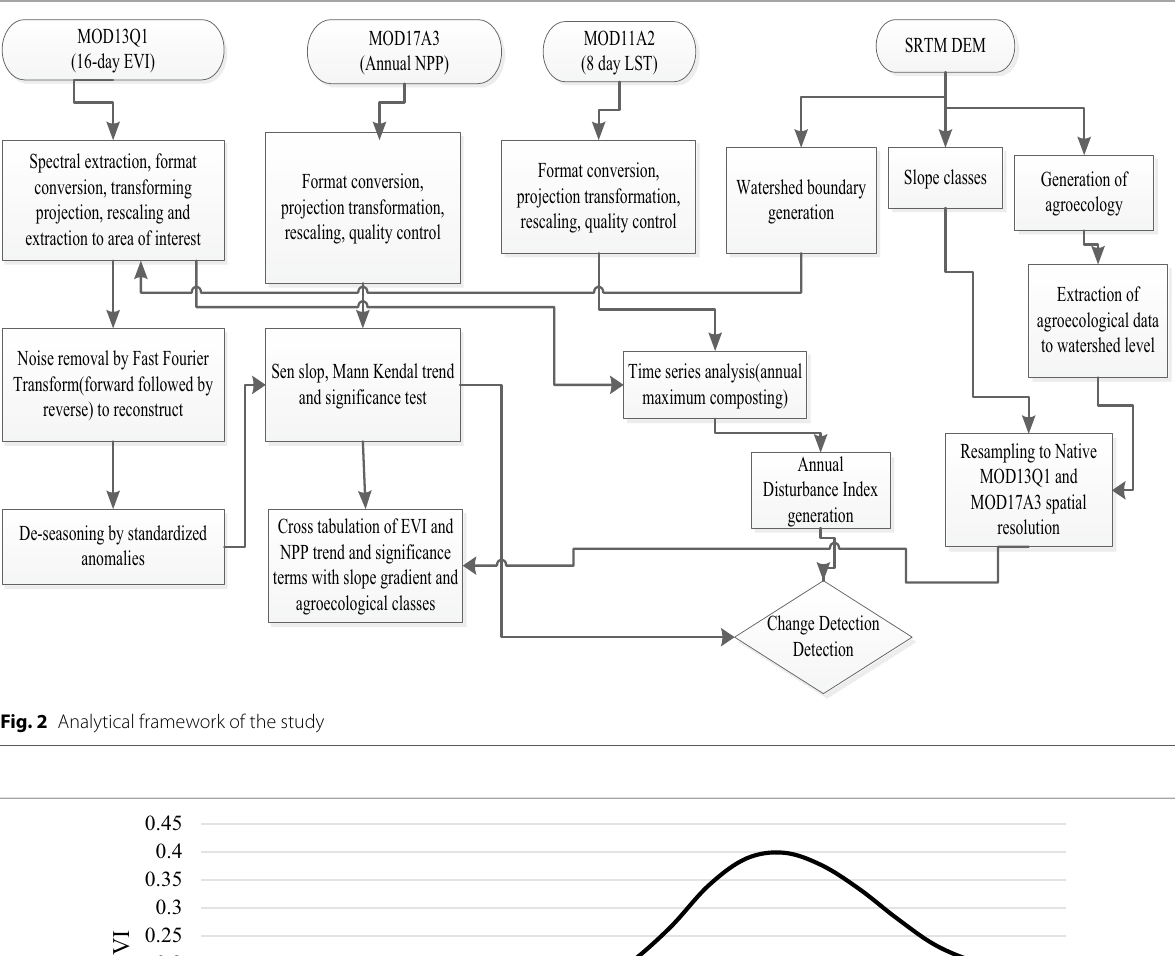
Fig. 2 Analytical framework of the study